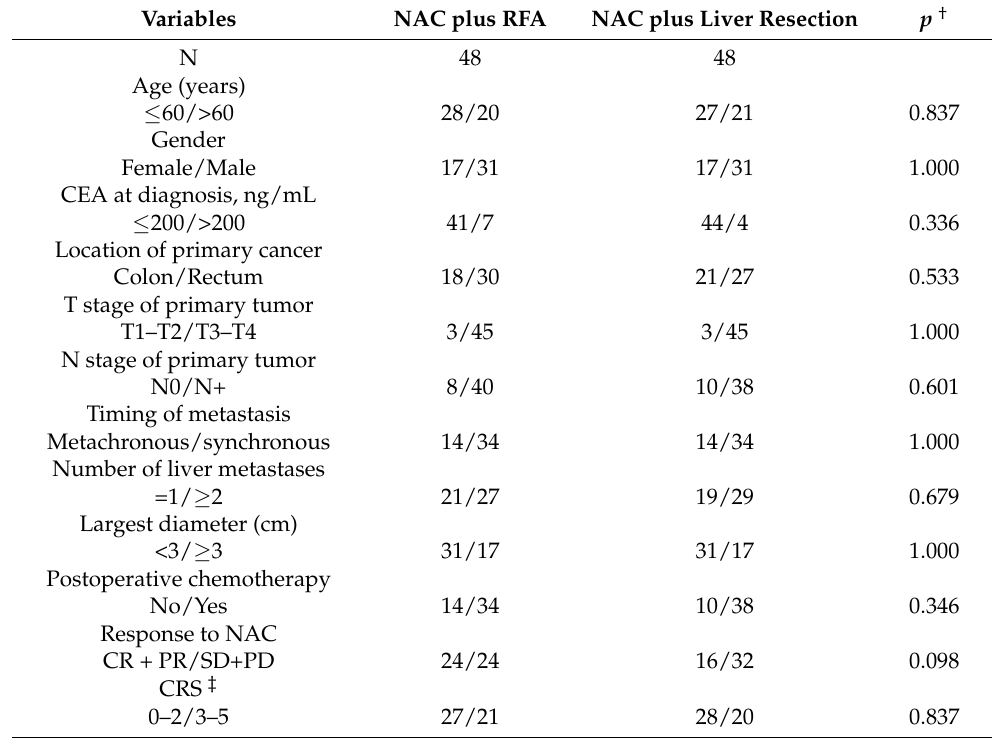
Table 2. Baseline characteristics after PSM.